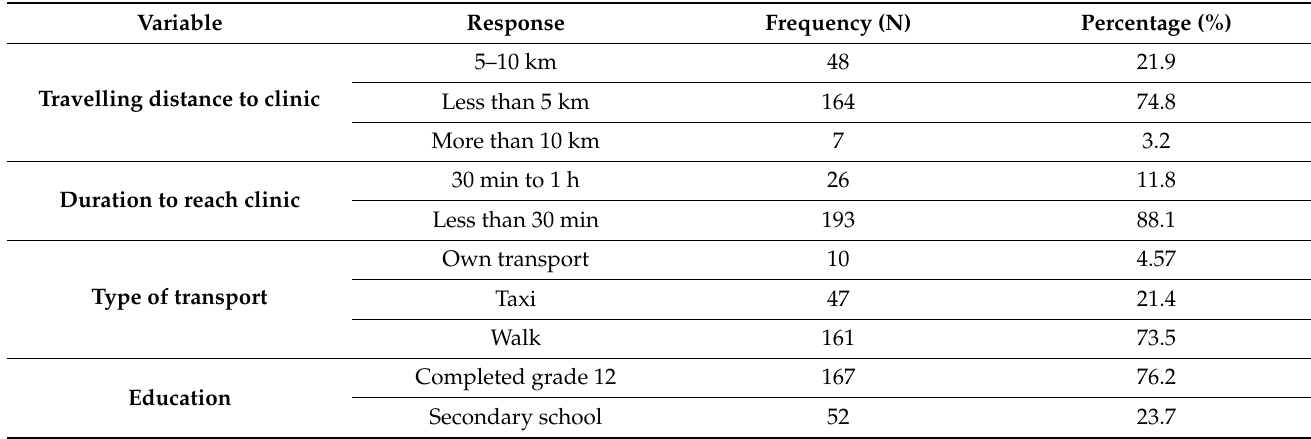
Table 1. Travelling distance, transport and education (n = 219).